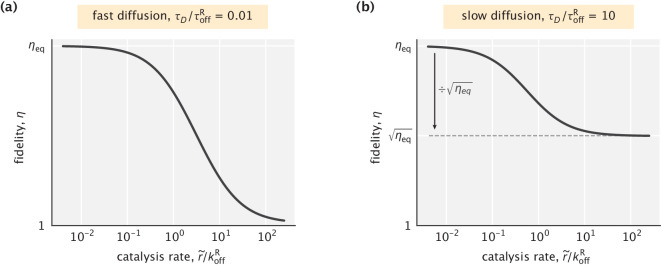
Dependence of fidelity on the catalysis rate in the case where the substrate profile is uniform.(a) Fast diffusion setting (τD⁢koffR≪1). The highest fidelity reduction is a factor of ηeq. (b) Slow diffusion setting (τD⁢koffR≳1). The highest fidelity reduction is a factor of ηeq. In both cases, ηe⁢q=10 was used.